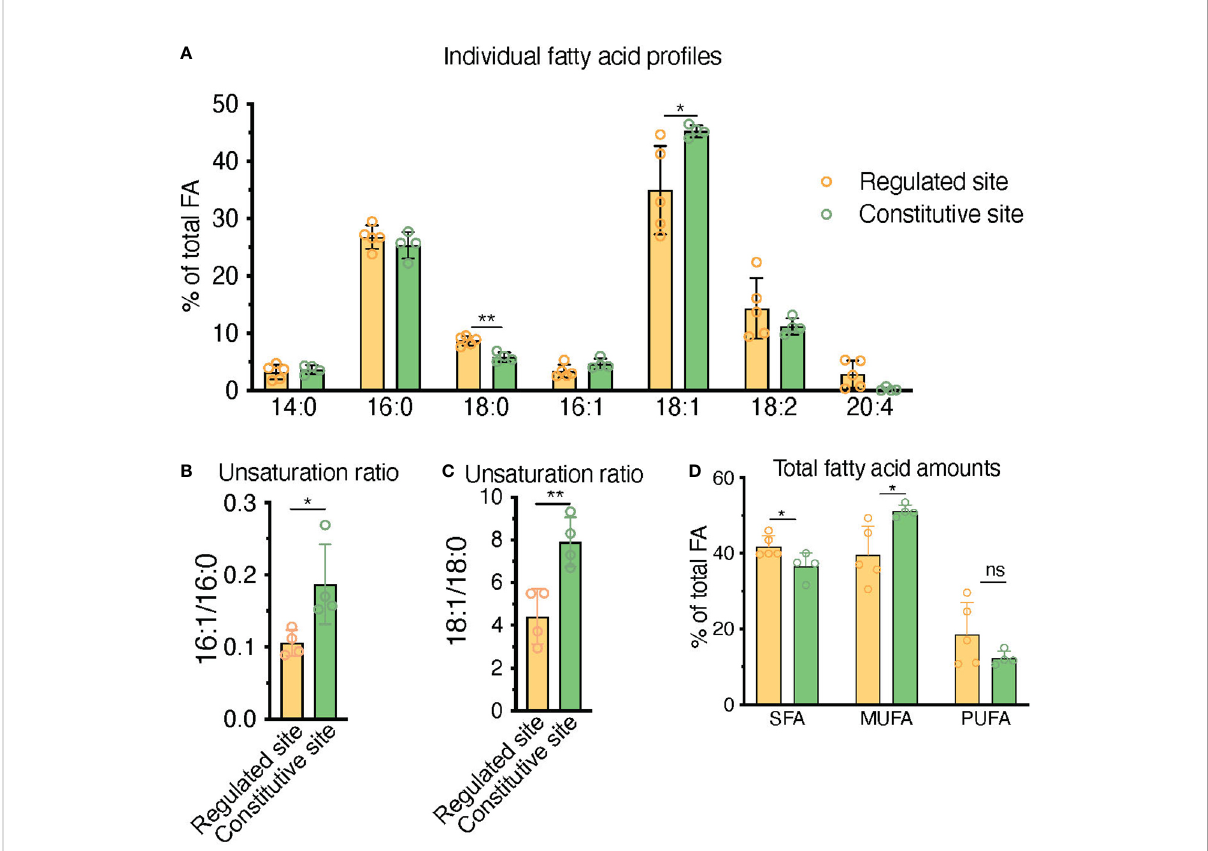
FIGURE 7 HPLC fatty acid quanti fi cation of primary human BM samples con fi rms a higher unsaturation ratio in constitutive BMAd-rich marrow (femoral head) versus regulated BMAd-rich marrow (ileac crest post-chemotherapy). (A – C) HPLC analysis of lipids isolated from human iliac crest bone marrow aspirates after induction chemotherapy (regulated site, labile marrow) or from the bone marrow offemoral specimens collected upon hip replacement surgery (constitutive site, stable marrow). (A) Higher unsaturation content in stable versus labile marrow oil reveal nuances of individual saturated, mono- , and polyunsaturated lipid species. (B, C) Greater unsaturation ratios in the human marrow from the constitutive site versus the regulated siten. (D) **P < 0.01, *P< 0.05 by student ’ s t-test. Error bars represent mean ± s.d. (n = 4 experiments from independent donors). Regulated site (iliac crest): 3 females, 1 male (age = 55 ± 12 years). Constitutive site (hip replacement): 3 males, 1 female (age = 68 ± 10